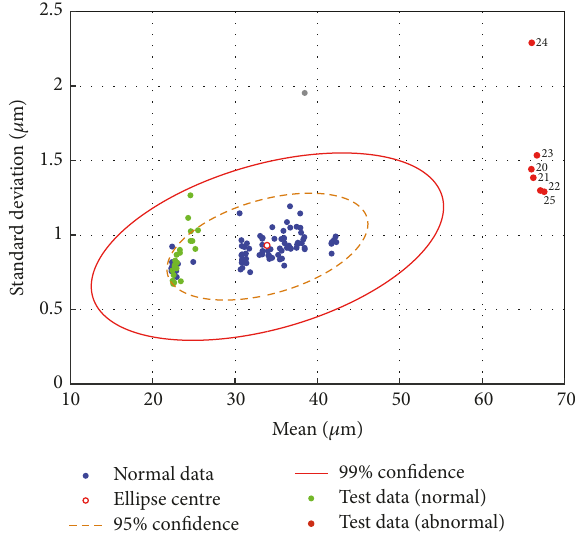
Figure 11: [CS2] Fingerprint envelope and novelty detection through GMMOC (months 1–4 and month 5).